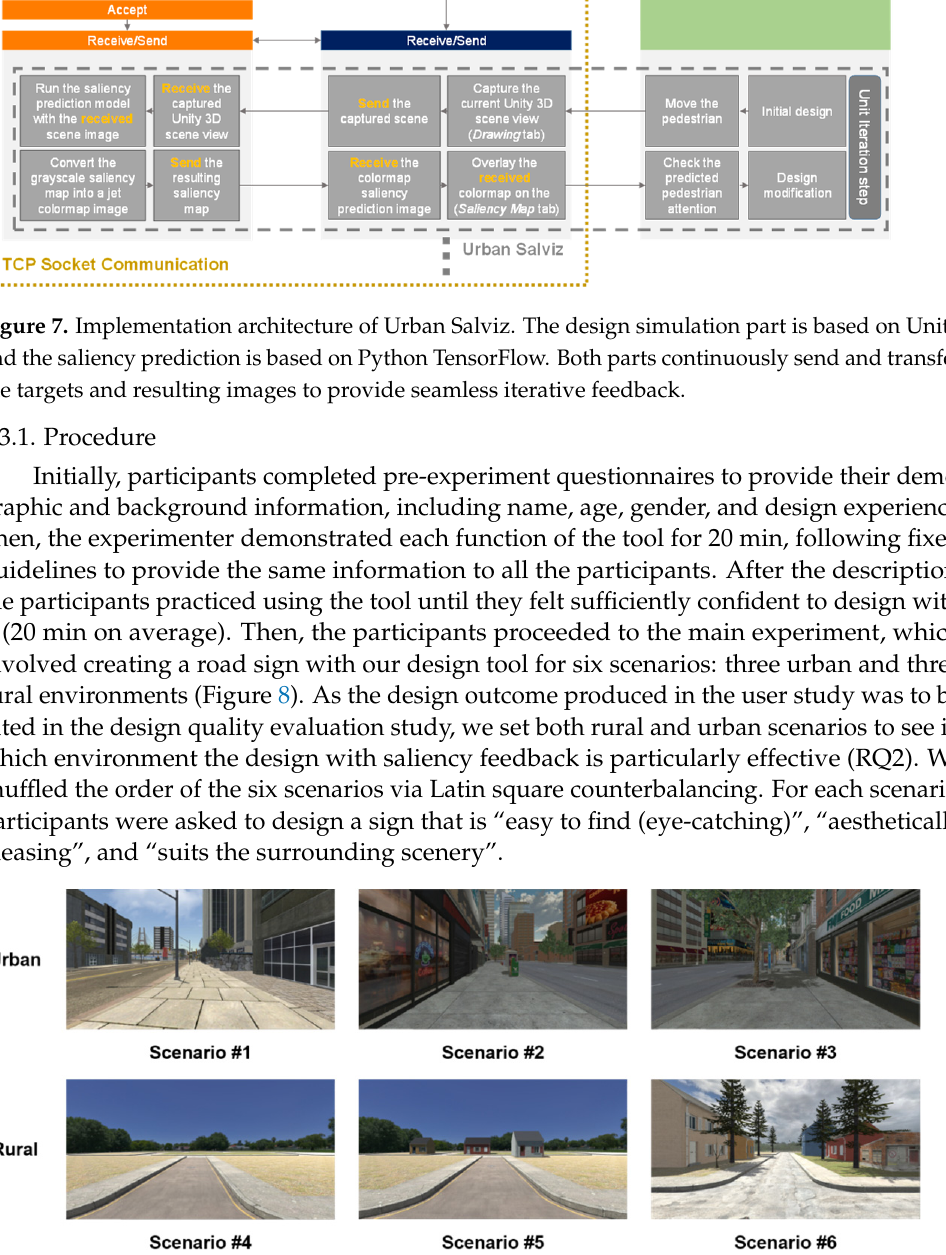
Figure 7. Implementation architecture of Urban Salviz. The design simulation part is based on Unity, and the saliency prediction is based on Python TensorFlow. Both parts continuously send and transfer the targets and resulting images to provide seamless iterative feedback.